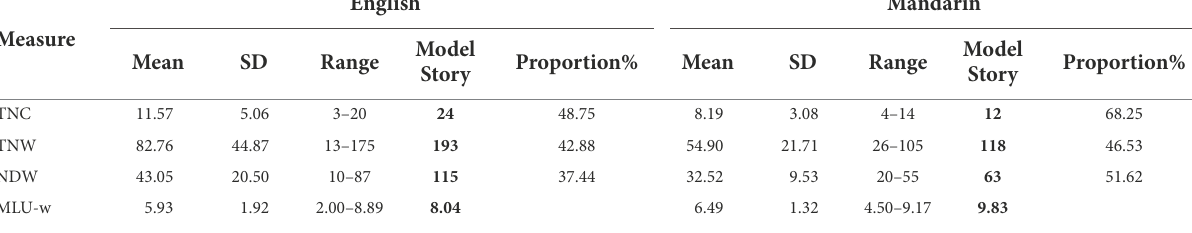
TABLE 3 Means, standard deviations (SD), and ranges on general microstructure measures of child productions compared to model stories in English and Mandarin.